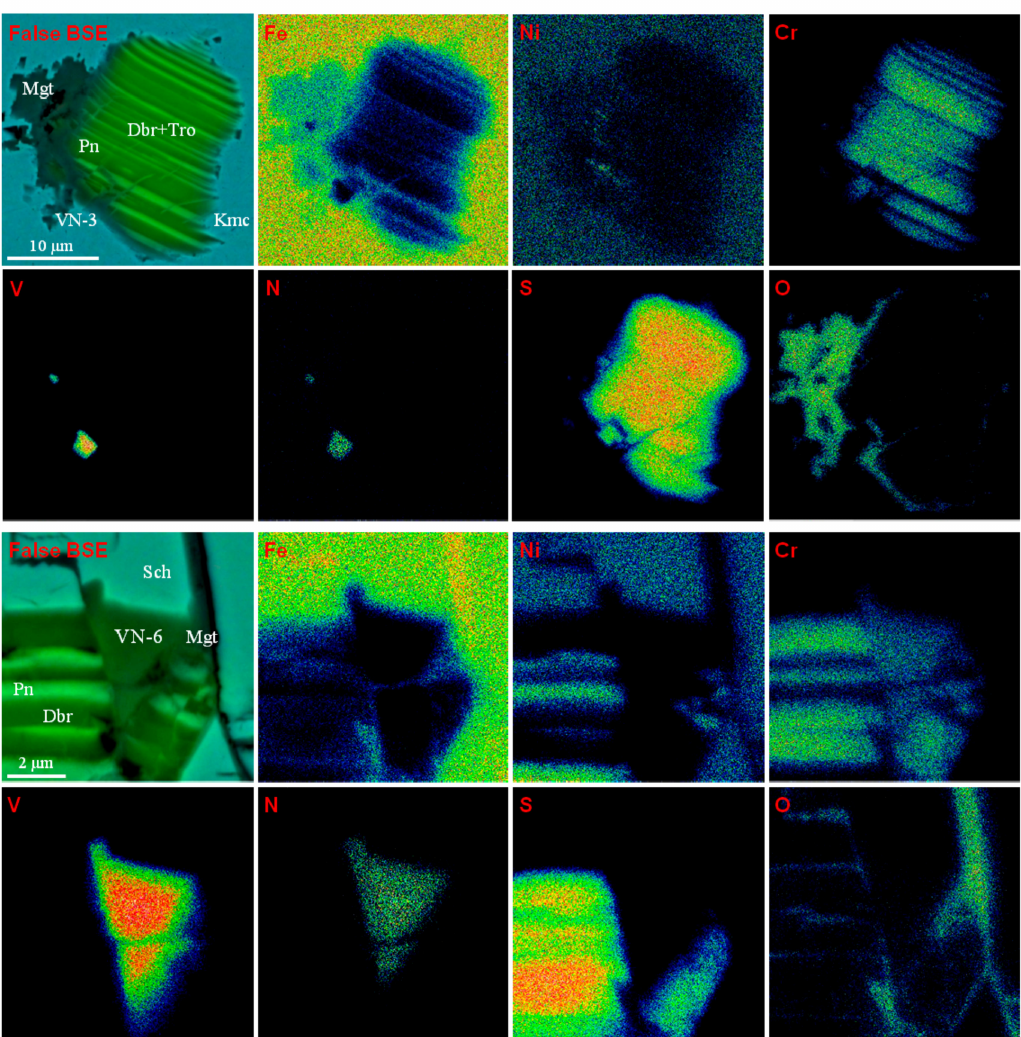
Figure 8. Elemental maps for troilite–daubr é elite globules with uakitite. Symbols: VN-3,